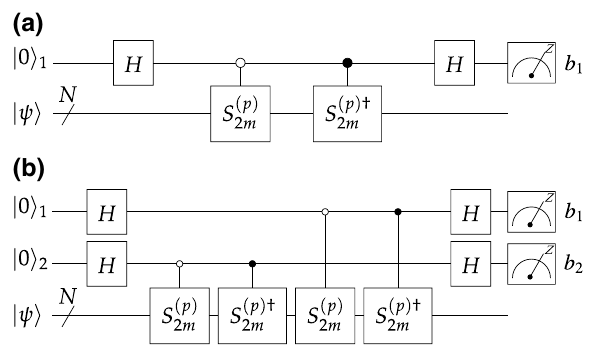
FIG. 2. Circuit with N register qubits and n ancilla qubits for probabilistically generating the state ∝ [ ˆ ( p ) ( − (cid:3) / 2 ) ] n | ψ (cid:3) in the register qubits for (a) n = 1 and (b) S τ 2 m ( p ) ( p ) † , and S in the circuit denote the Hadamard gate, n = 2. H , S 2 m 2 m ˆ ( p ) ((cid:3) / 2 ) , and ˆ S ( p ) ( − (cid:3) / 2 ) , respectively. A controlled-unitary S τ τ 2 m 2 m gate with a solid (open) circle indicates that the unitary gate is applied only if the control qubit is set to 1 (0). The probabil- for finding the bit string b 1 b 2 · · · b n = 11 · · · 1 in the ity P b 1 b 2 ··· b n ancilla qubits is given in Eq.